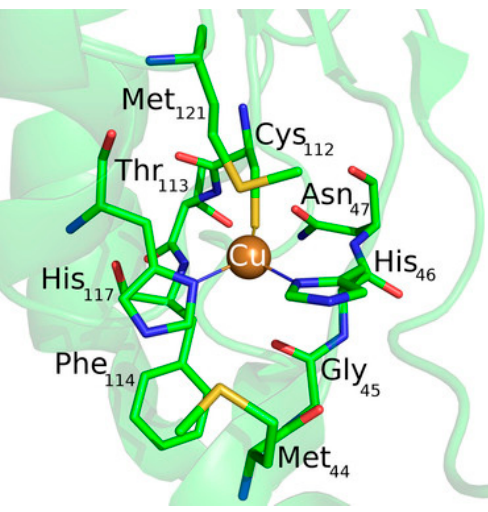
Figure 10. Active site structure of azurin as drawn from the 4AZU pdb file. Reprinted with per- mission from [140]. Copyright (2017) Wiley-VCH. from [140]. Copyright (2017)